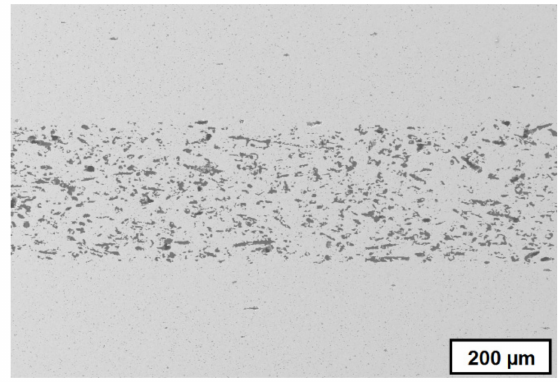
Figure 3. Cross-section of sintered MgO–ZrO 2 component with graded microstructure (manufactured by group “Shaping”, FhG-IKTS).